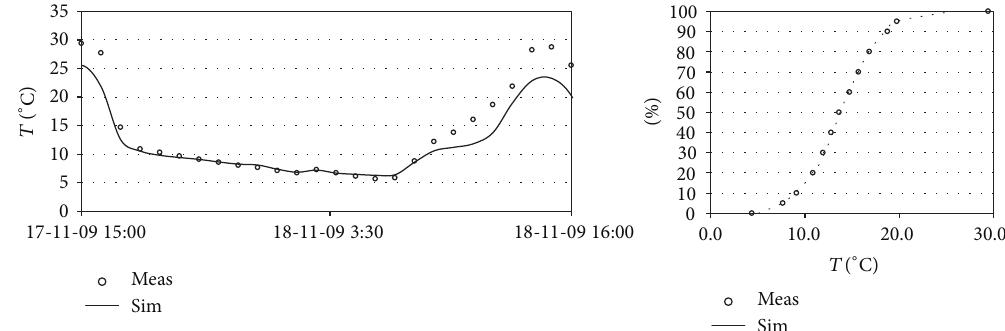
Figure 8: Variation in time and the cumulative distribution function of surface temperature on west fac¸ade in November 2009, with clear sky (measurements versus numerical simulation).